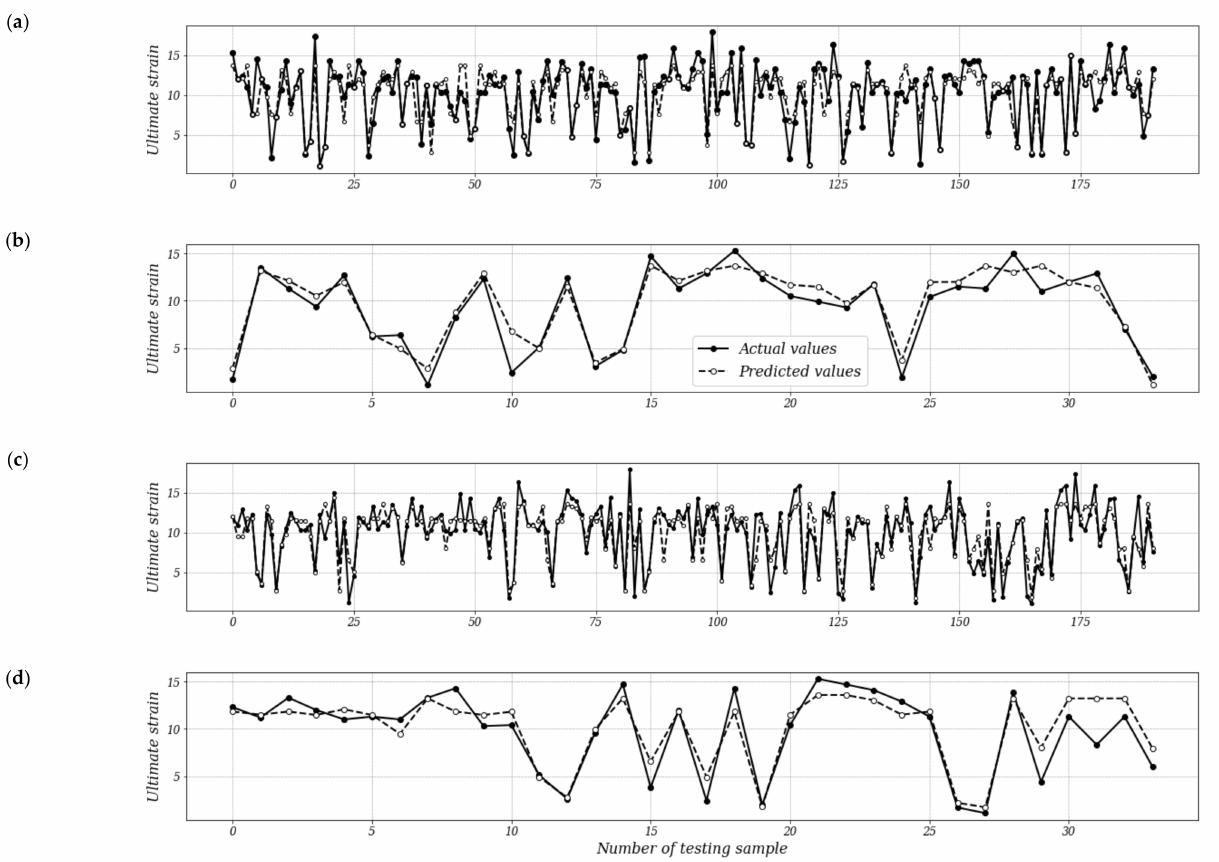
Figure 7. Actual and estimated values: ( a ) DT: training, ( b ) DT: testing, ( c ) RF: training, and ( d ) RF: